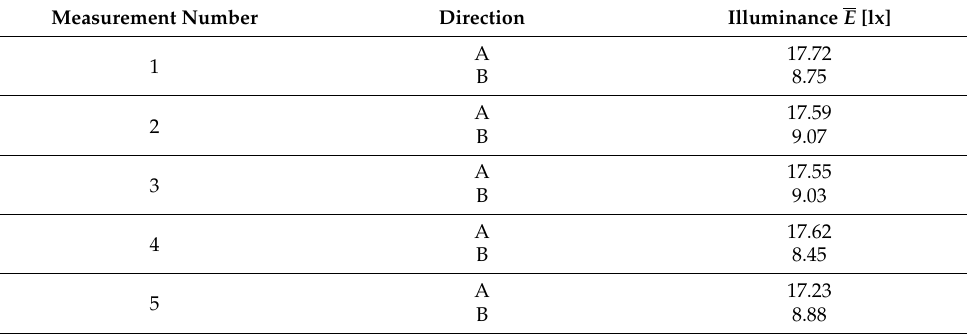
Table A7. Example of the results for measurement field No. 11.